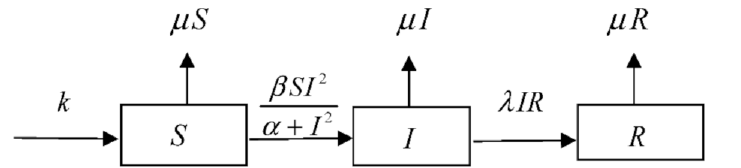
Figure 1. Structure of the rumor-spreading process with Holling type III functional